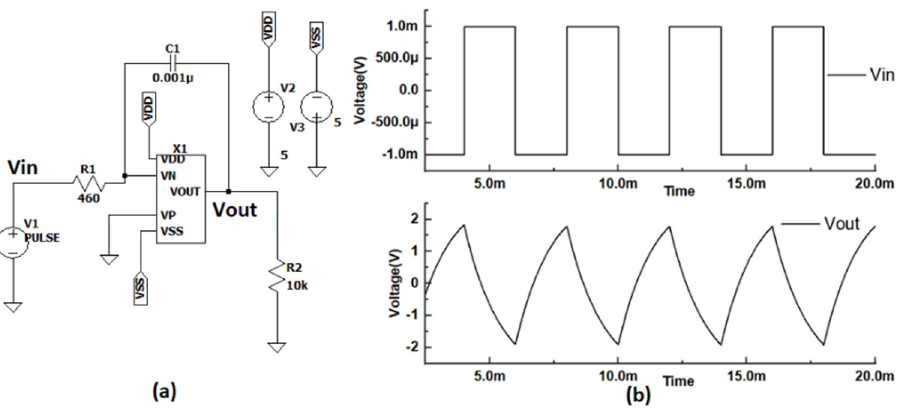
Figure 8. ( a ) Integrator circuit. ( b ) Simulation output.